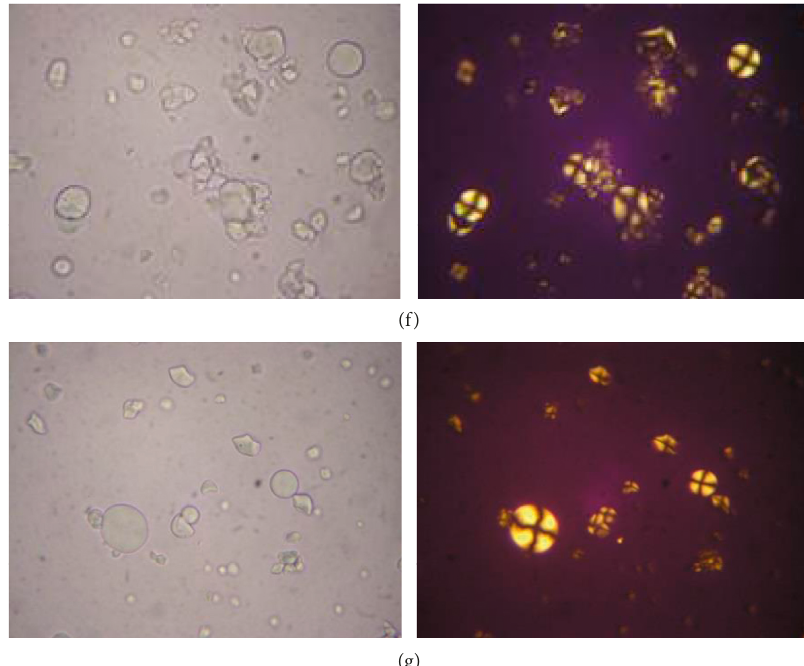
Figure 1: Light micrographs of raw and malic acid-treated sweet potato starches (magnification 400 × ): (a) raw, (b) 2.0M-25, (c) DW-130,